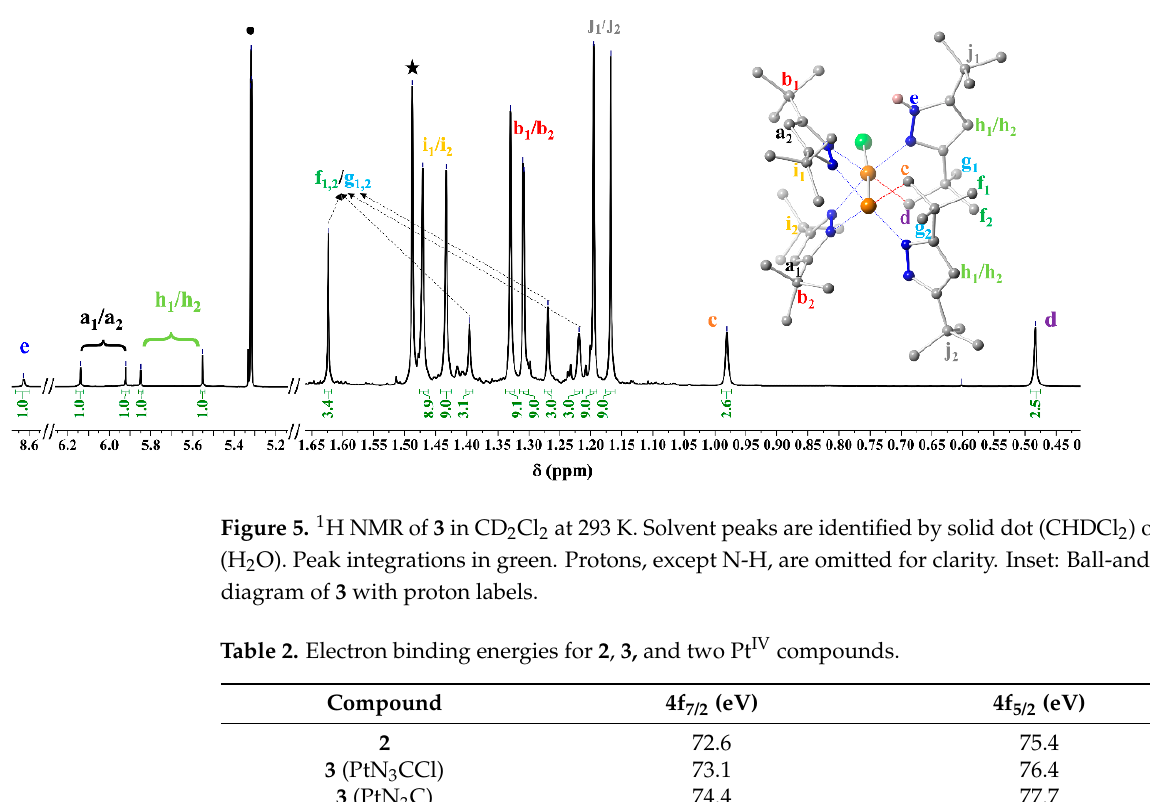
Figure 4. Two ball-and-stick views of the structure of 3 . Color code: C, black; H, pink; N, blue; Pt, grey; Cl, green. H atoms, except for N-H, are not shown for clarity.